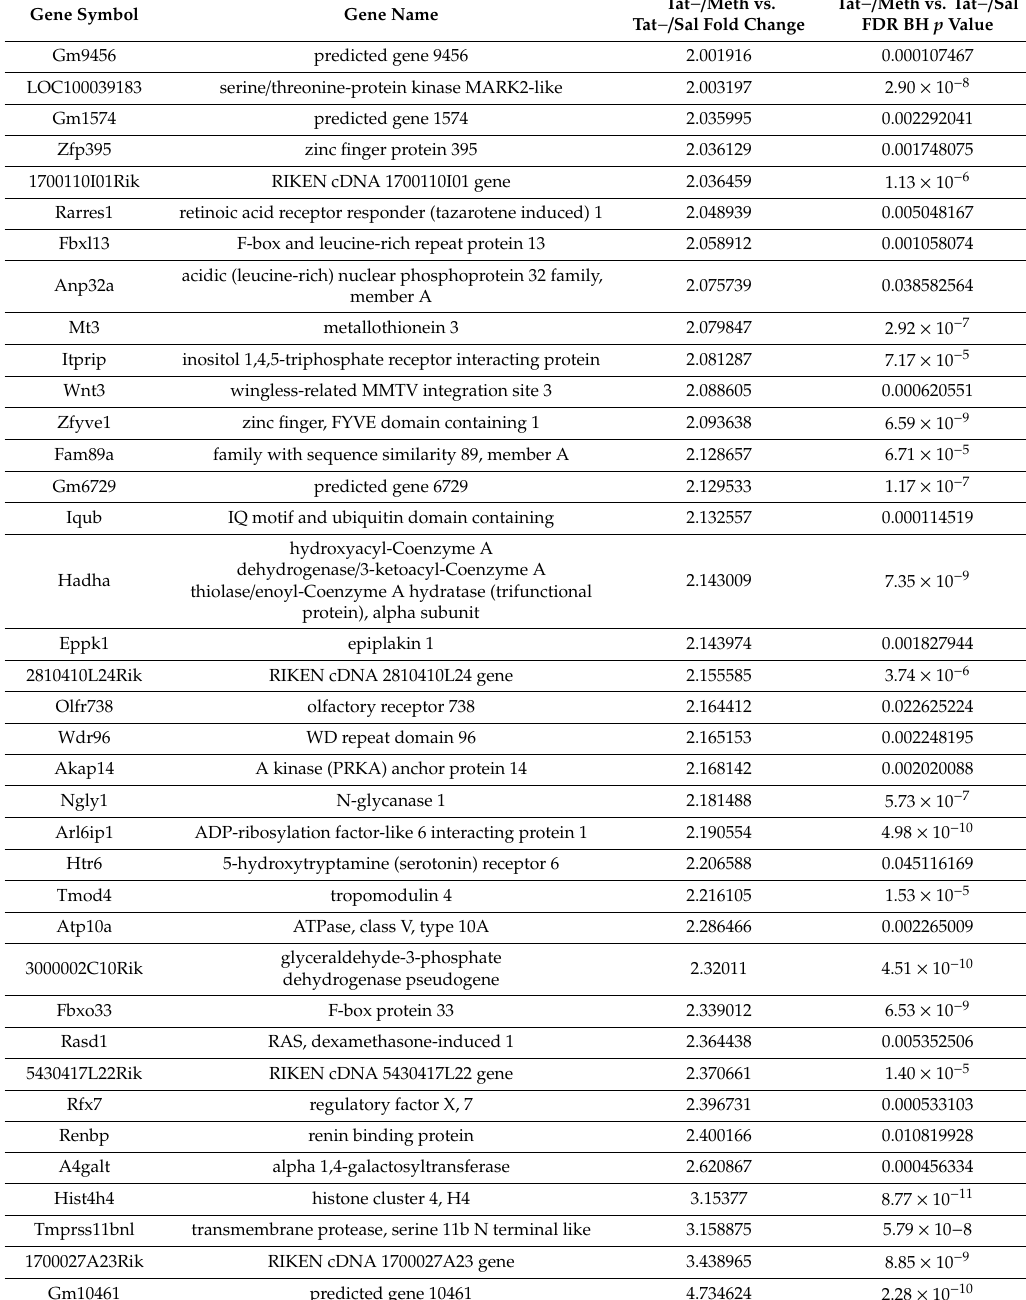
Table 3. Genes significantly a ff ected by Tat − / Meth as compared with the Tat − / Sal